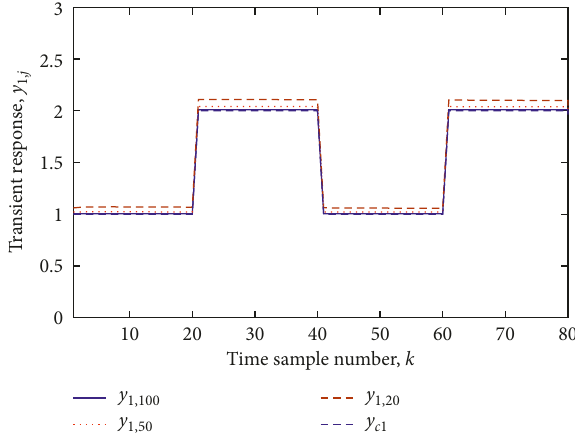
Figure 9: Output y